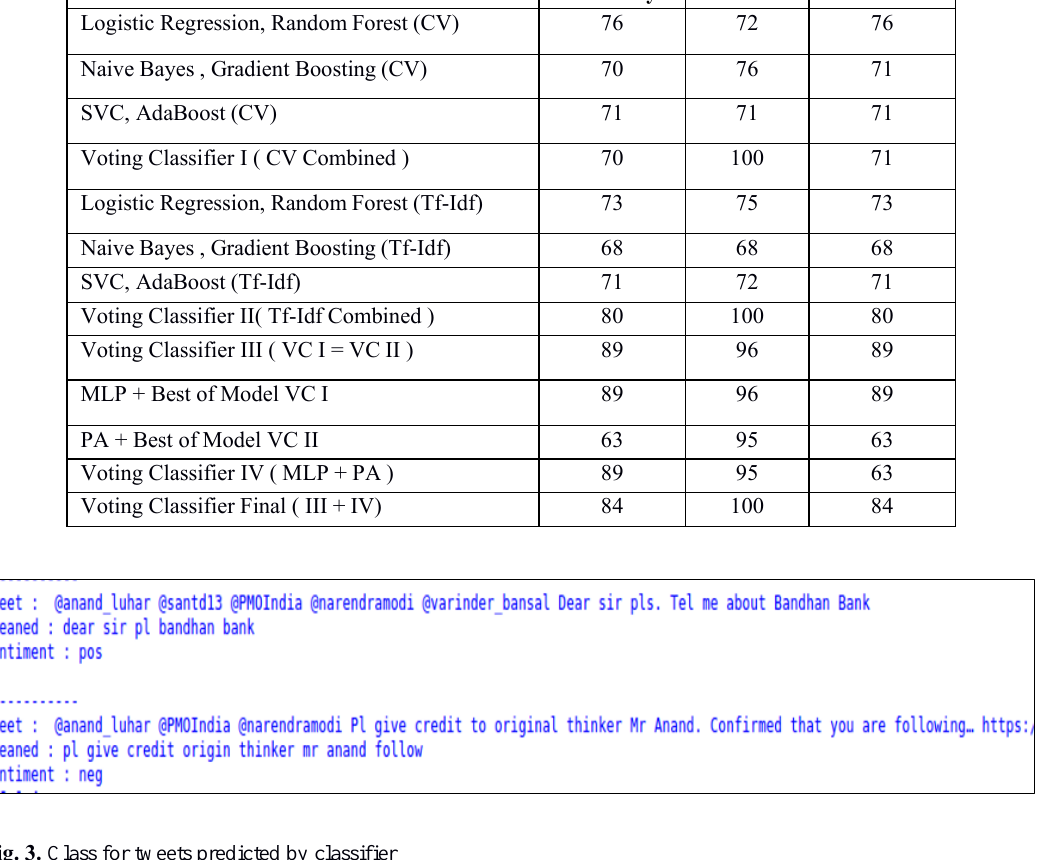
Fig. 3. Class for tweets predicted by classifier